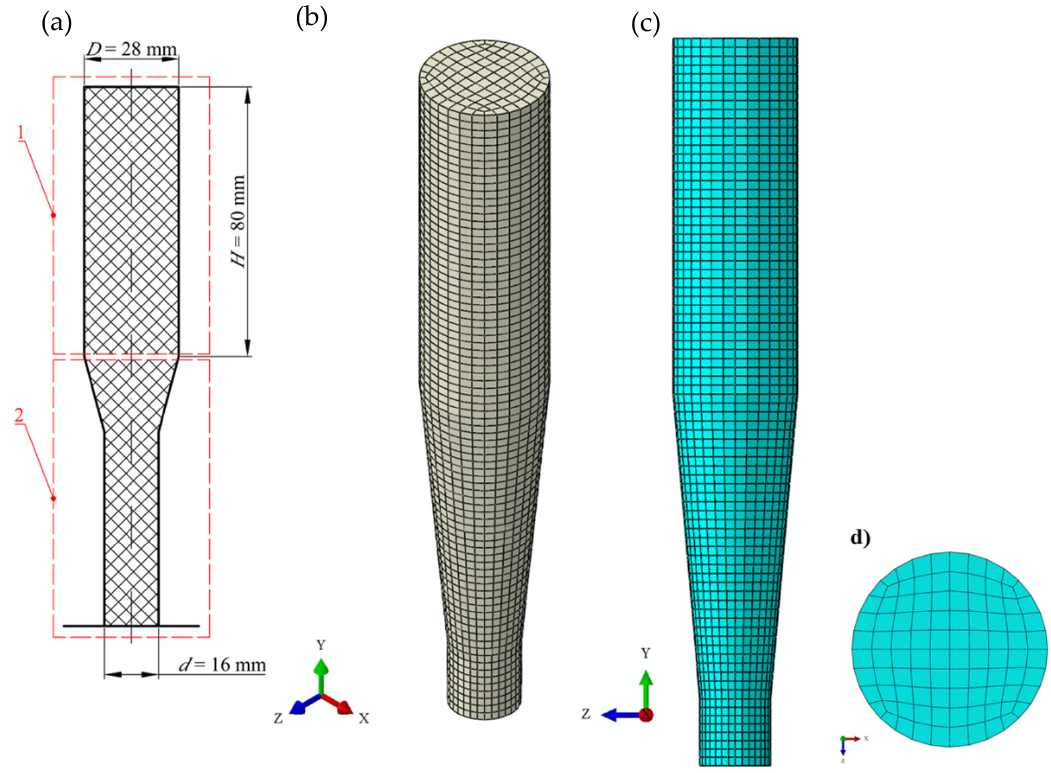
Figure 6. Shape and distribution of finite elements using an example of the compressed material model: ( a ) dimensions, ( b ) overview, ( c ) distribution of finite elements over a plane parallel to the axis of symmetry, ( d ) distribution of finite elements over a plane perpendicular to the axis of symmetry; 1—feed barrel area, 2—single-hole die area.